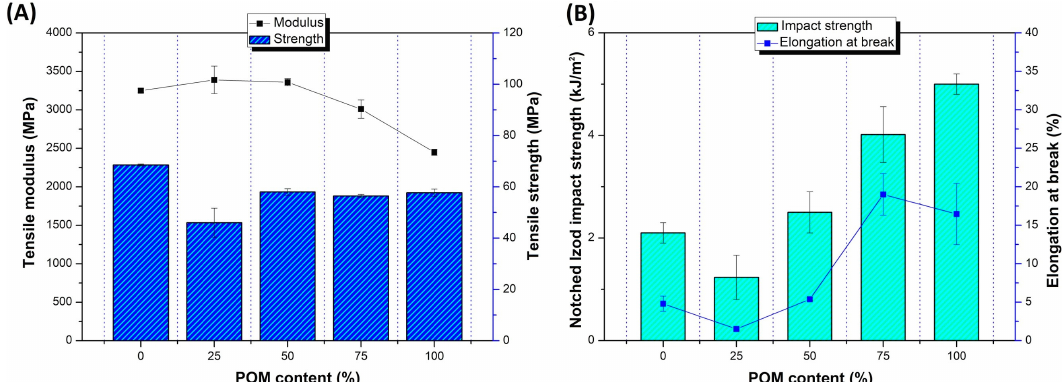
Figure 1. The mechanical properties of unmodified blends and reference polyoxymethylene (POM) and poly(lactic acid) (PLA) samples. Tensile modulus and strength ( A ); elongation at break and Izod notched impact strength ( B ).